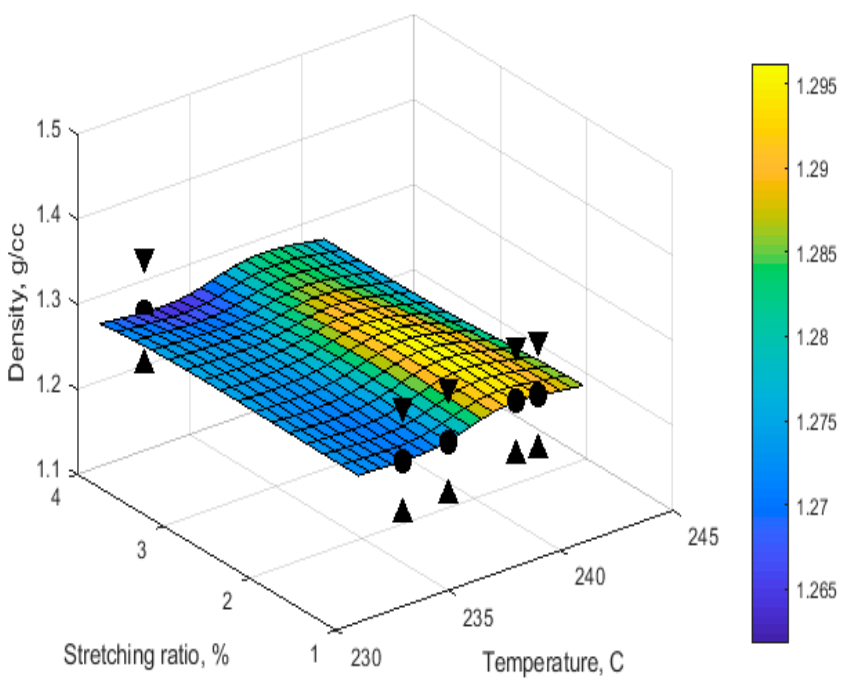
Figure 3. Temperature-stretching ratio relationship with density at space velocity of 20 m/min using Support Vector Regression (SVR); the triangle marks show the prediction error.